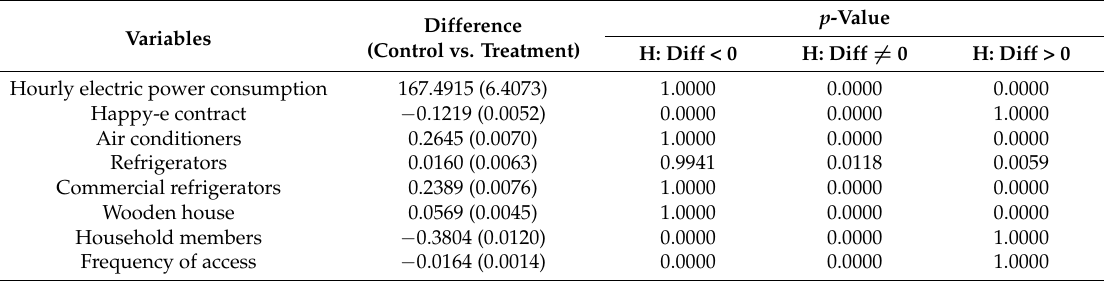
Table 3. Differences between the control and treatment